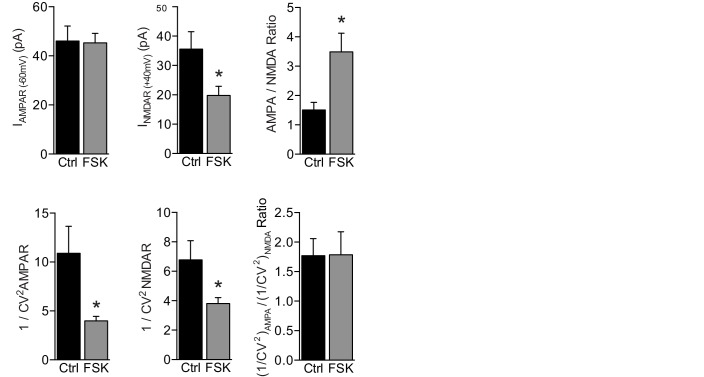
Forskolin increases postsynaptic AMPAR currents.Evoked EPSC amplitude and quantal content (1/CV2) of AMPAR EPSCs, NMDAR EPSC, and AMPA/NMDA EPSC ratio upon stimulation of Schaffer collateral axons (as seen in Figure 3A) of WT CA1 neurons with (n=13) or without (n=9) forskolin. AMPAR responses of approximately 50 pA in amplitude were evoked while holding the CA1 neuron at −60 mV. The same stimulation intensity was maintained at +40 mV to measure NMDAR responses, which were significantly smaller in the presence of forskolin (t-test, p=0.03), leading to increased AMPA/NMDA ratios (t-test, p=0.01). By applying a variance analysis on these AMPAR and NMDAR responses, we quantified the average quantal content of glutamate release by determining the inverse square of the coefficient of variation (1/CV2). The 1/CV2 depends on the presynaptic release probability (Pr) and number of effective synapses (N), but not on postsynaptic quantal size, as: 1/CV2=N×Pr ⁄ (1 − Pr) (Kerchner and Nicoll, 2008). In the presence of forskolin the 1/CV2 of both AMPAR and NMDAR responses was significantly lower (AMPAR: t-test, p=0.001; NMDAR: t-test, p=0.04). Thus, a lower quantal content induced proportionally lower NMDAR responses but similarly sized AMPAR responses when forskolin was present. One explanation for this observation is that forskolin caused a decrease in Pr, which was reflected by lower NMDAR responses but not AMPAR responses, because it was accompanied by an increase in the postsynaptic AMPAR response to glutamate. However, a lower Pr does not match the increased mEPSC frequency in Figure 3C. A more plausible explanation therefore is that on average fewer synapses need to be stimulated in the forskolin condition to evoke synaptic AMPAR responses of the same amplitude, and this lower number of stimulated synapses led to correspondingly lower NMDA currents. In both scenarios, forskolin increased postsynaptic AMPAR currents without substantially changing NMDAR currents, and did not increase the presynaptic release probability. Forskolin incubation did not change the relative quantal content measured from AMPAR and NMDAR responses (t-test, p=0.7), which suggests that the activation of GluA2/3-plasticity in WT neurons did not involve the unsilencing of synapses. Error bars indicate SEM, * indicates p<0.05.